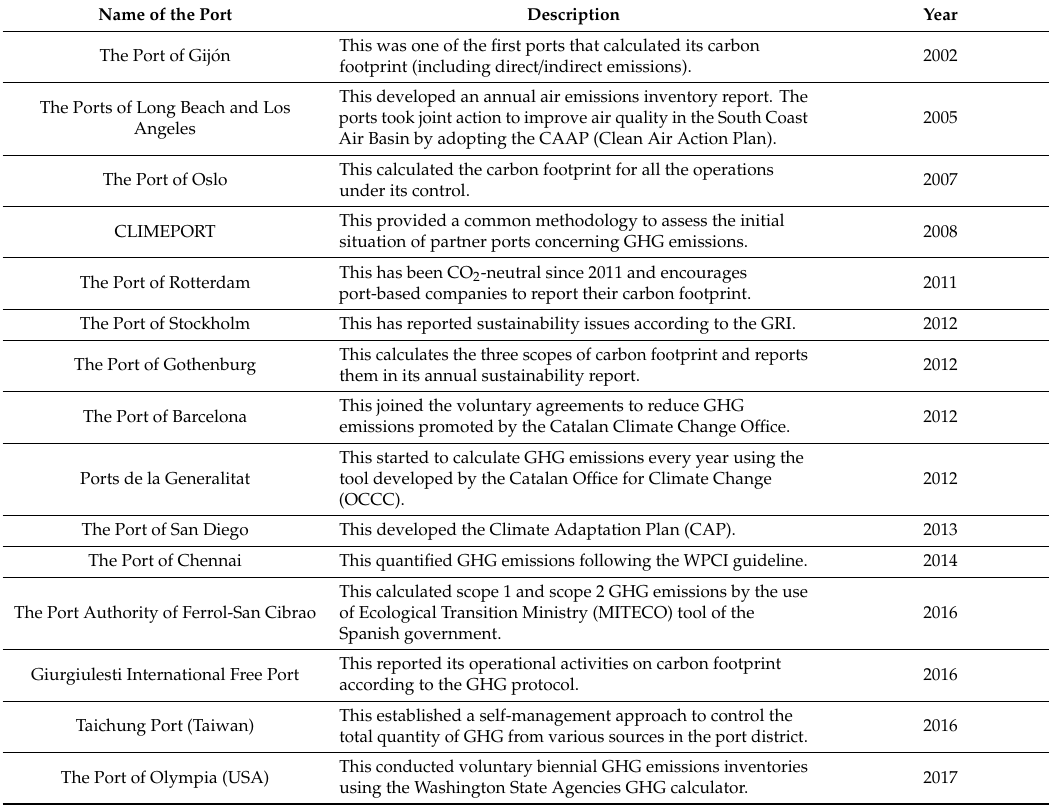
Table 3. Existing methodologies to calculate carbon footprint in